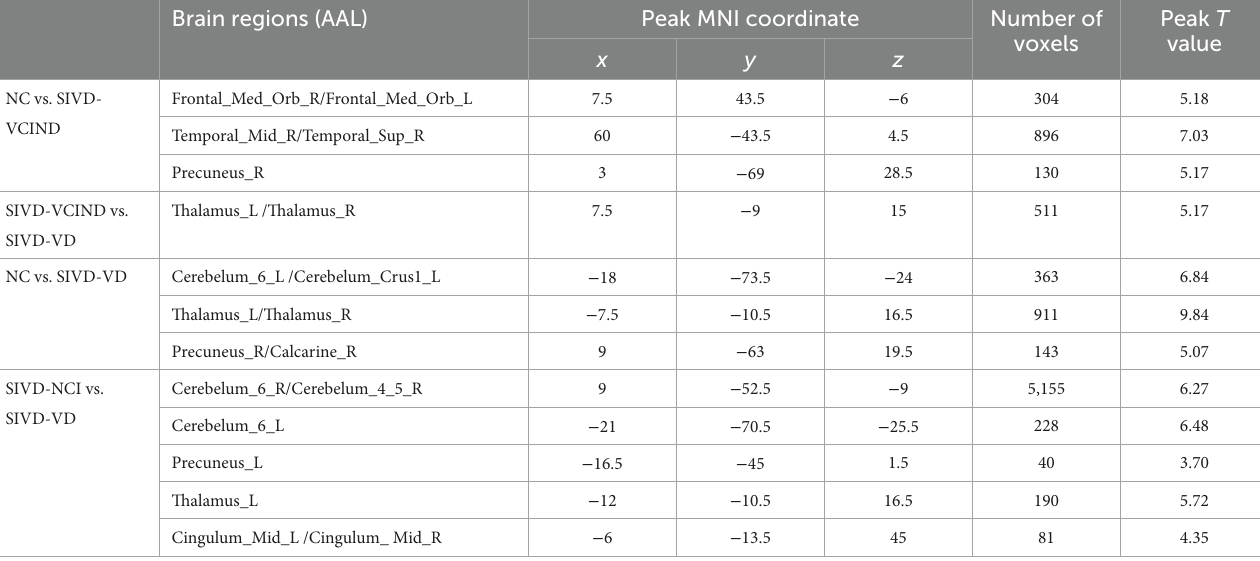
TABLE 4 Comparison of gray matter reduction areas among the four groups ( p < 0.05, FWE corrected). Brain regions (AAL) Peak MNI coordinate